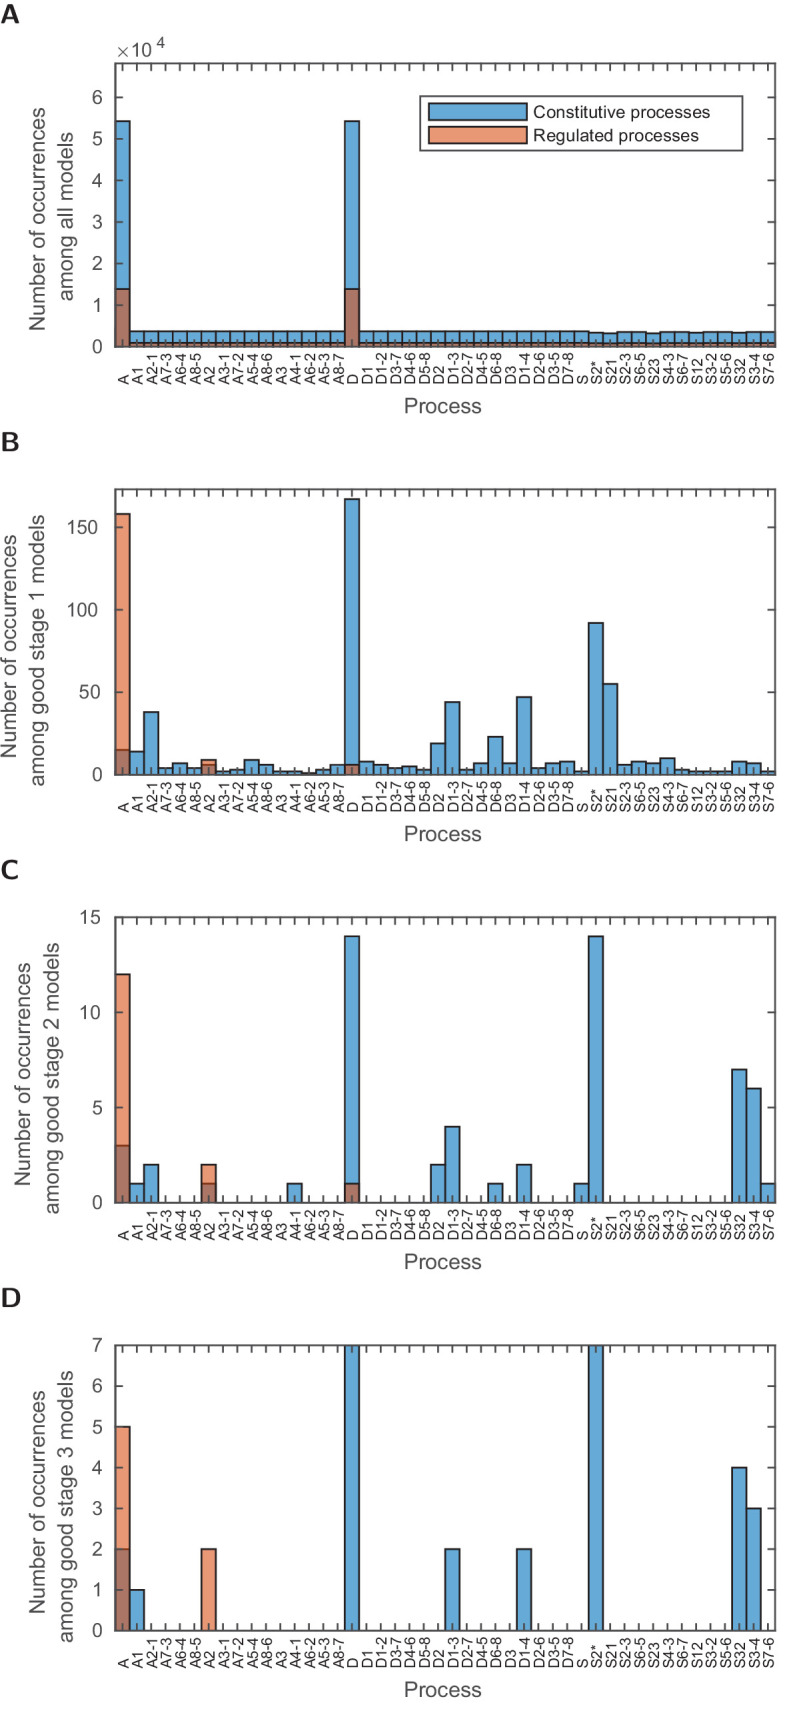
Occurrences of the different processes in the models with satisfactory likelihood at the different stages.(A) In all 68,145 analyzed models, (B) in all 173 good models of stage 1, (C) in all 15 good models of stage 2, (D) in all seven satisfactory models after stage 3. In each plot, the y-axis limit is the number of the considered models allowing the comparison of the relative occurrences between the four cases.